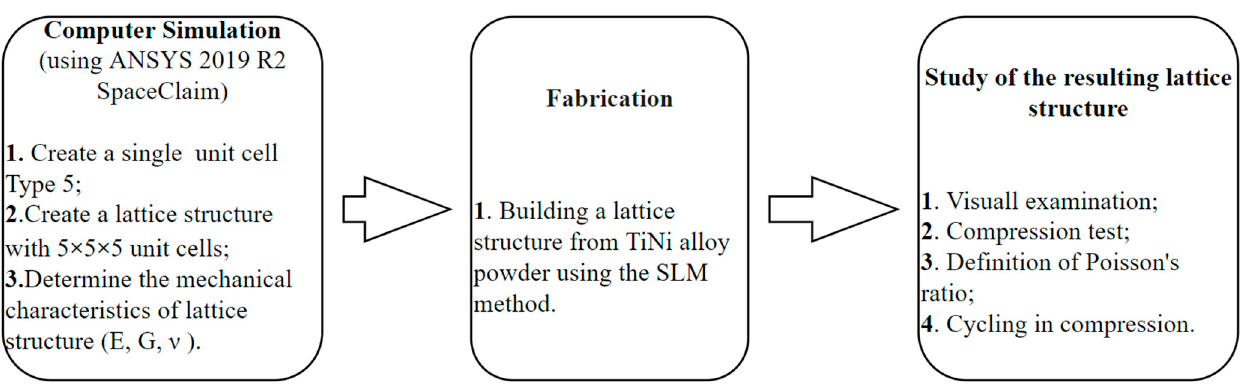
Figure 1. Block diagram of the study.